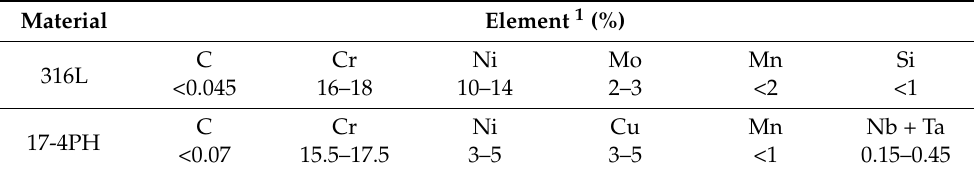
Table 1. Chemical composition of the 316L and 17-4PH stainless steel